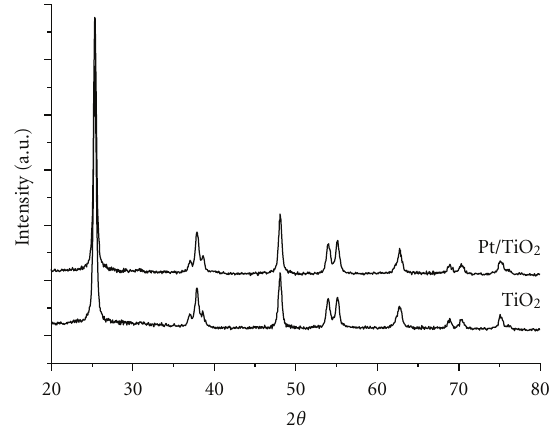
Figure 1: XRD patterns for TiO 2 and Pt/TiO 2 photocatalysts.